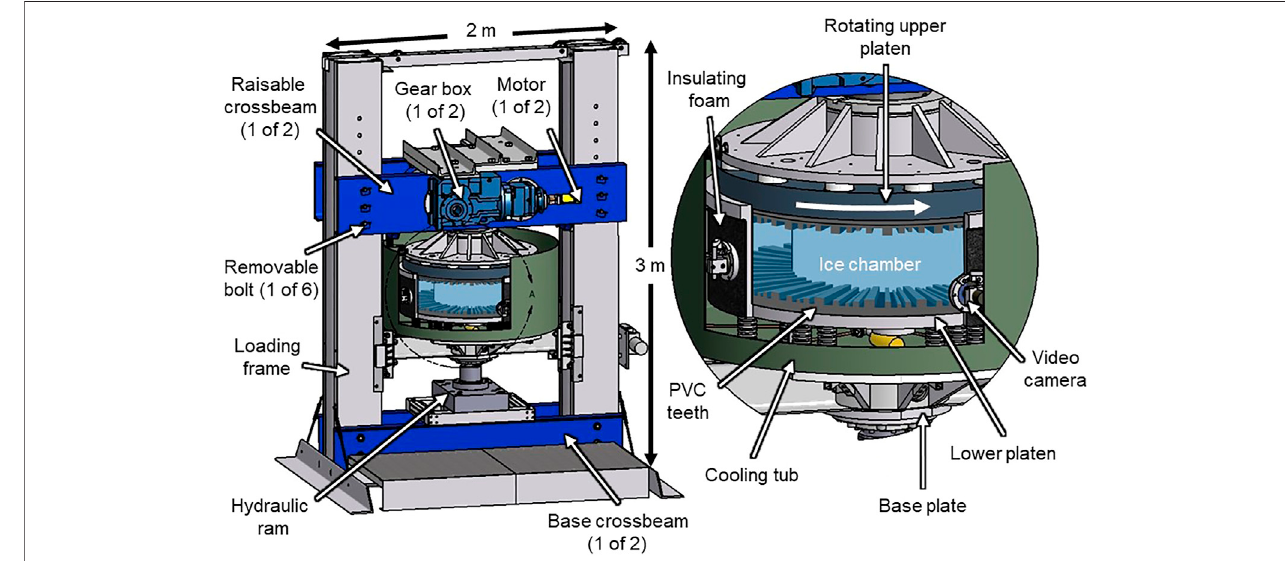
FIGURE 2 | Schematic of the ring-shear device, con fi gured as a viscometer.